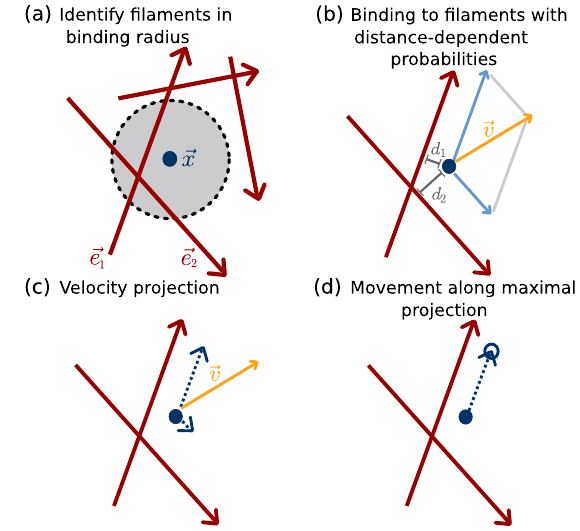
FIG. 2. Schematic of the molecular simulation procedure. (a) The motor (blue dot) can associate with filaments (red vectors) within a defined binding radius. (b) Active attachments are assigned stochastically in a distance-dependent fashion. The velocity vector that results from each active attachment moving a step along its filament is computed. (c) The velocity vector is projected onto the filaments. (d) The motor takes a step with size proportional to the magnitude of the largest velocity projection, along the associated